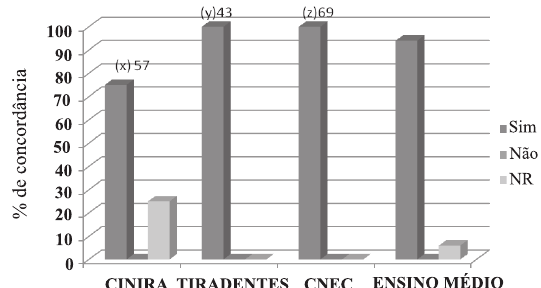
Figura 6. reconhecimento da importância do ensino de Microbiologia do Solo no ensino médio (x, y e z, nº total de entrevistados em cada escola; as barras “ensino médio” representam a média geral das três escolas) pelos